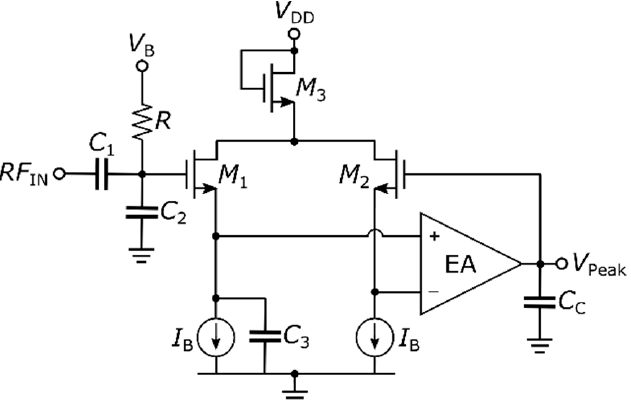
Figure 3. Simplified schematic of the peak detector.